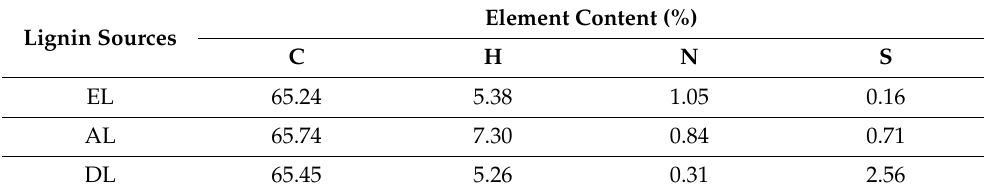
Table 1. Chemical characteristics of the nitrogen − doped porous carbons.